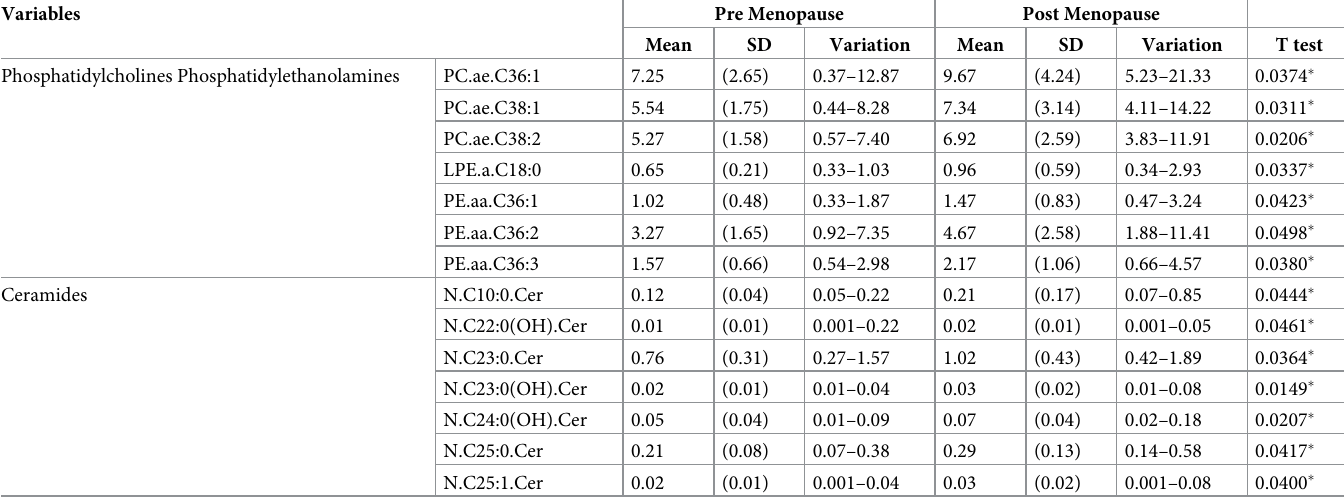
Table 3. Average concentrations (μM) of lipid a species among in the women, in the pre-menopause and post-menopause. São Luı´s, Maranhão, 2013.